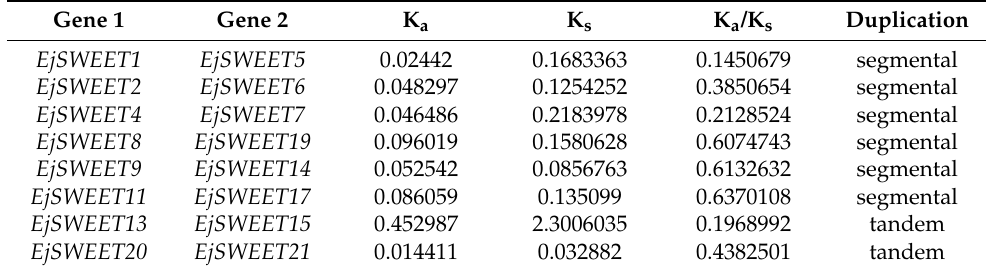
Figure 3. Chromosomal mapping ( A ) and gene duplication ( B ) of EjSWEETs . Table 4. The K a /K s ratio of duplicated EjSWEET